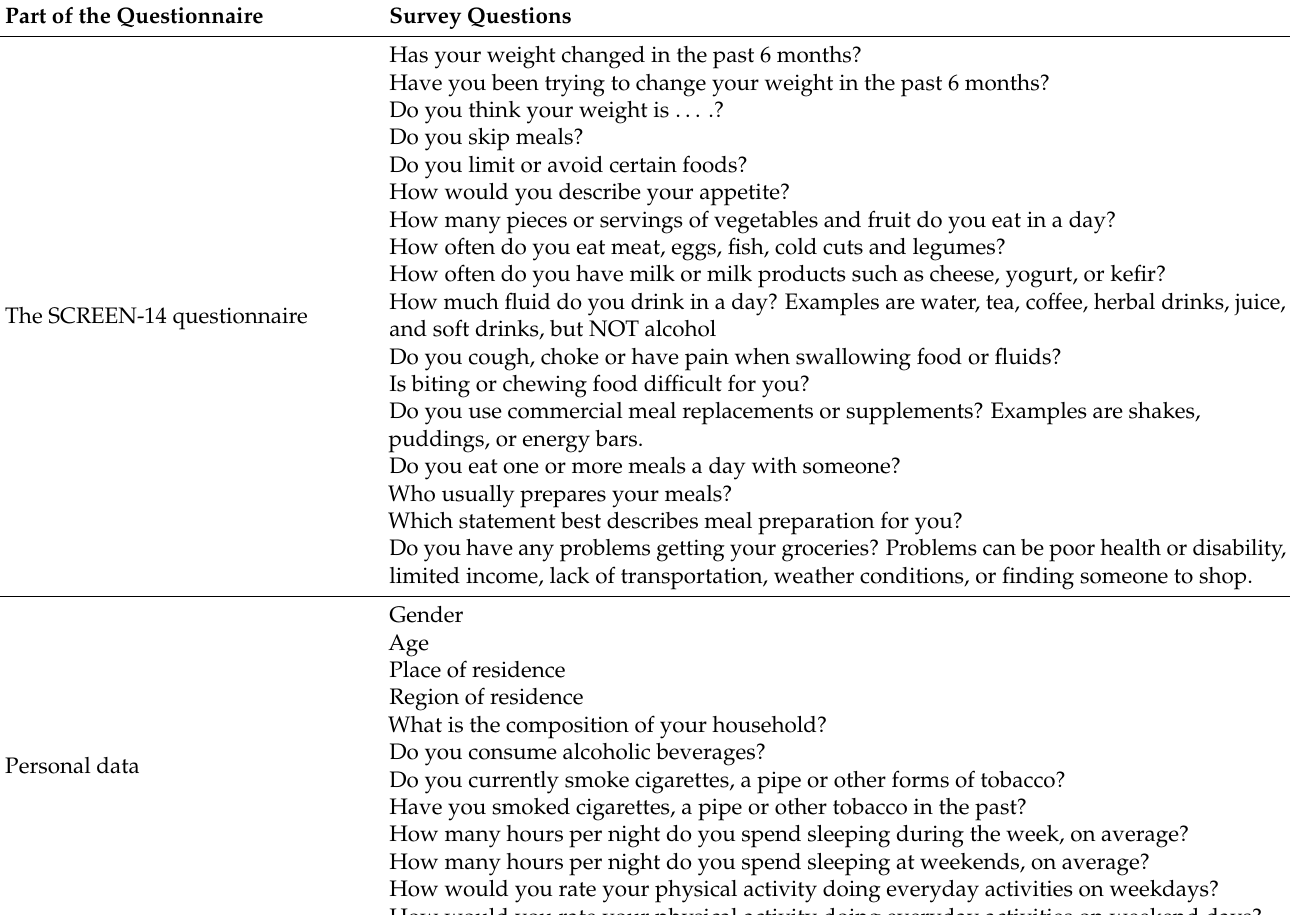
Table 1. Questionnaire